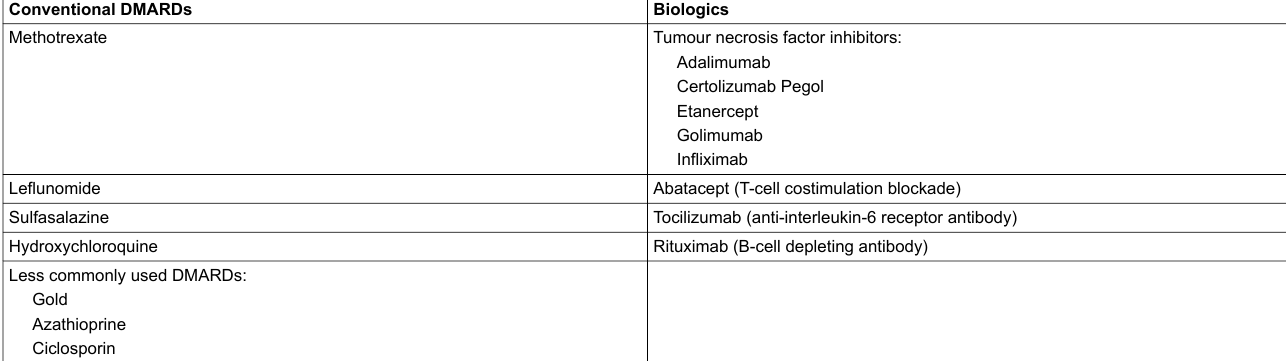
Table 1: Conventional disease-modifying antirheumatic drugs (DMARDs) and biologics licensed in Switzerland for the treatment of rheumatoid arthritis. Conventional